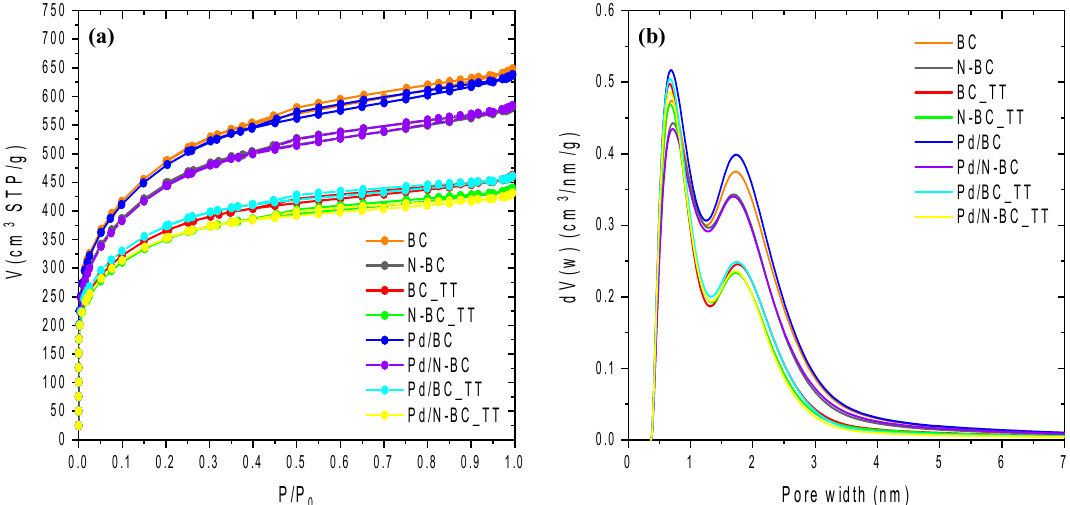
Figure 1. N 2 adsorption–desorption isotherms at − 196 ◦ C of carbon supports and Pd-based catalysts ( a ) and their pore size distribution ( b ). Table 1. Porous texture characterization.